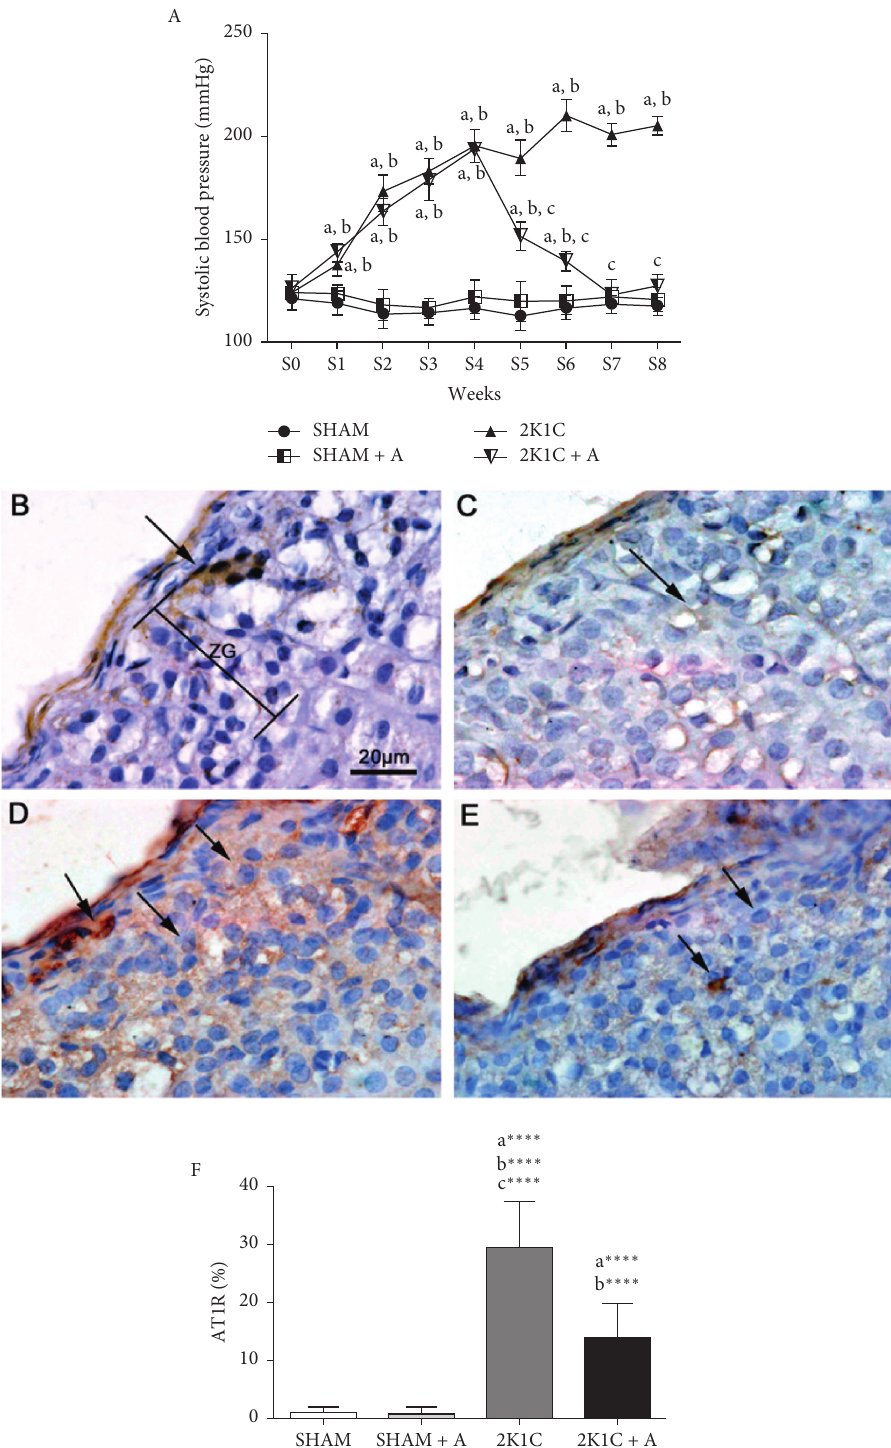
Figure 1: Evolution of blood pressure and detection and quantification of AT1R expression. (A) Evolution of SBP in millimeters of mercury (mmHg). Detection of AT1R expression by immunohistochemistry in the (B) SHAM group, (C) SHAM +A, (D) 2K1C, and (E) 2K1C +A. (F) Quantification of AT1R expression in the zona glomerulosa of the adrenal gland of all experimental groups. Arrows indicate the immunostained positive cells. ZG, zona glomerulosa. (a) represents ≠ to the SHAM group, (b) represents ≠ to the SHAM+A group, and (c) represents ≠ to the 2K1C +A group. ∗∗∗∗ p < 0 . 0001. n � 10 for all experimental